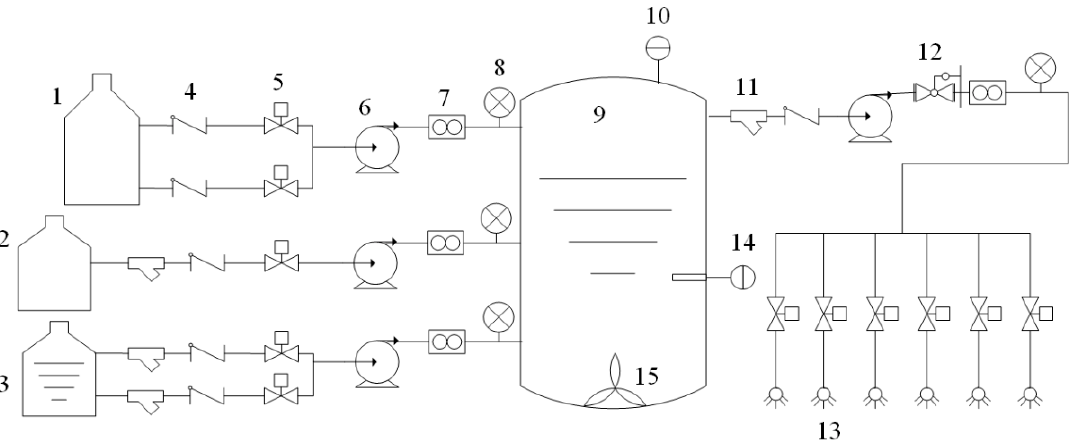
Figure 1. Structural block diagram of pH value regulation system of liquid fertilizer: 1, regulating liquid tank; 2, fertilizer tank; 3, water storage tank; 4, check valve; 5, solenoid valve; 6, hose pump; 7, flowmeter; 8, pressure gauge; 9, mixing tank; 10, liquid level gauge; 11, Y-type filter; 12, pressure holding valve; 13, drip irrigation belt; 14, pH sensor; 15, mixing pump.